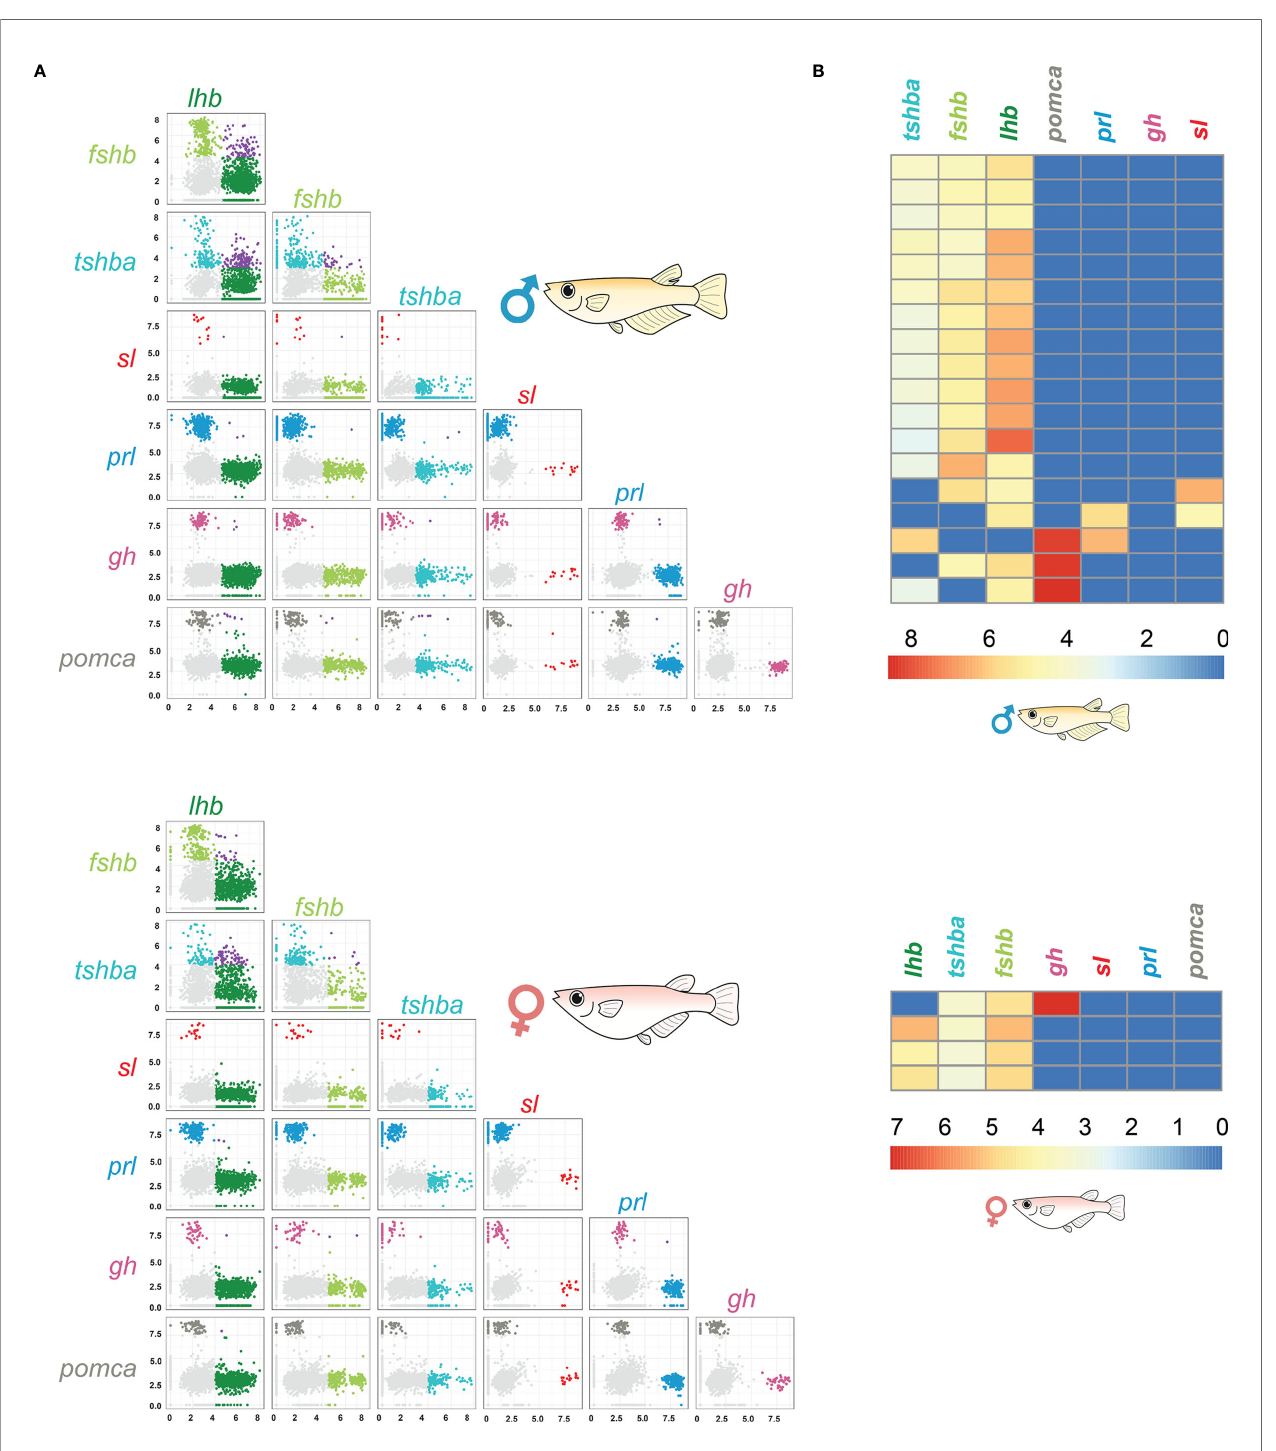
FIGURE 5 | scRNA-seq data reveal the presence of bi-hormonal and multi-hormonal cells in the medaka pituitary. Pair wise plots of 2228 cells in female and 3245 cells in male pituitary (A) . Colored by fi ltered cells (light gray), lhb expressing cells (light green), fshb expressing cells (dark green), tshba expressing cells (cyan), sl expressing cells (red), prl expressing cells (blue), gh expressing cells (magenta), pomca expressing cells (dark grey) and cells expressing more than one endocrine gene (purple). Light grey cells represent the cells where gene expression for the investigated hormone is considered as part of the background. Axes are log normalized. Zoom in from the heatmap of seven hormone-encoding genes of the male and female pituitary shown in Supplementary Figure 15 , displaying the cells expressing more than two hormone-encoding genes (B) . Each row represents one cell, and low expressions are shown in blue and high expressions are shown in red. For all hormone-encoding genes, expression levels below the threshold established in Supplementary Figure 1 were replaced by zero and thus appear in